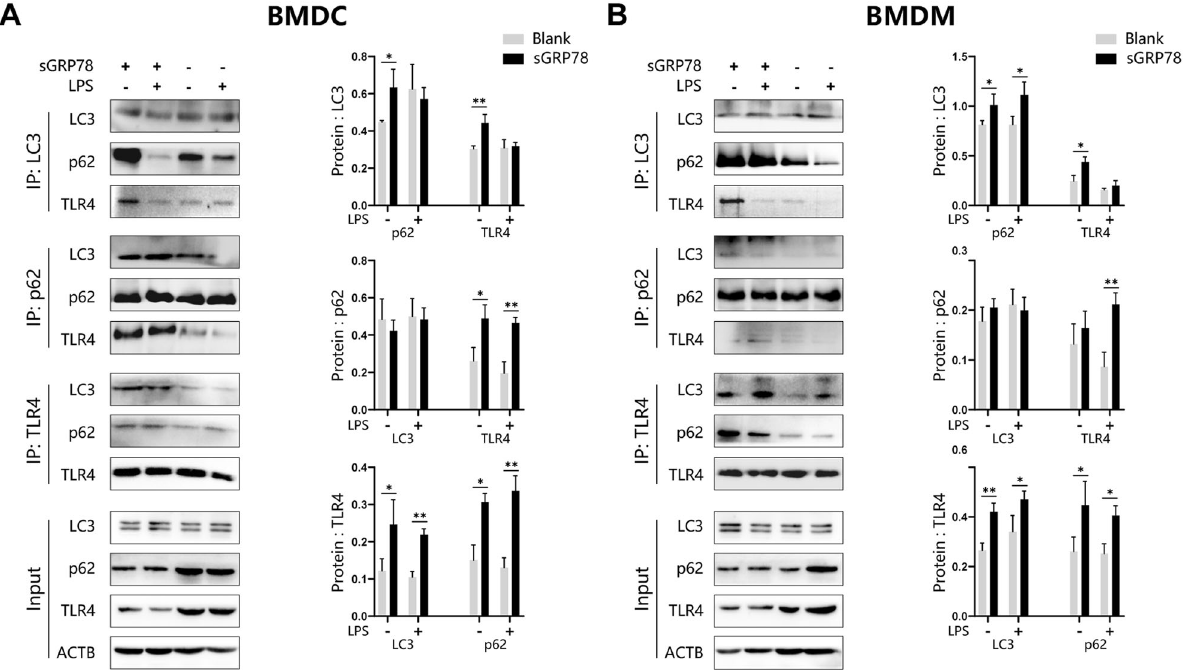
Fig. 4 sGRP78 promotes selective autophagy of intracellular TLR4. BMDCs ( A ) and BMDMs ( B ) were treated with sGRP78 and/or LPS for 12 h. Whole-cell lysates were immunoprecipitated with anti-LC3, anti-p62 or anti-TLR4 antibody, respectively. * P < 0.05, ** P <